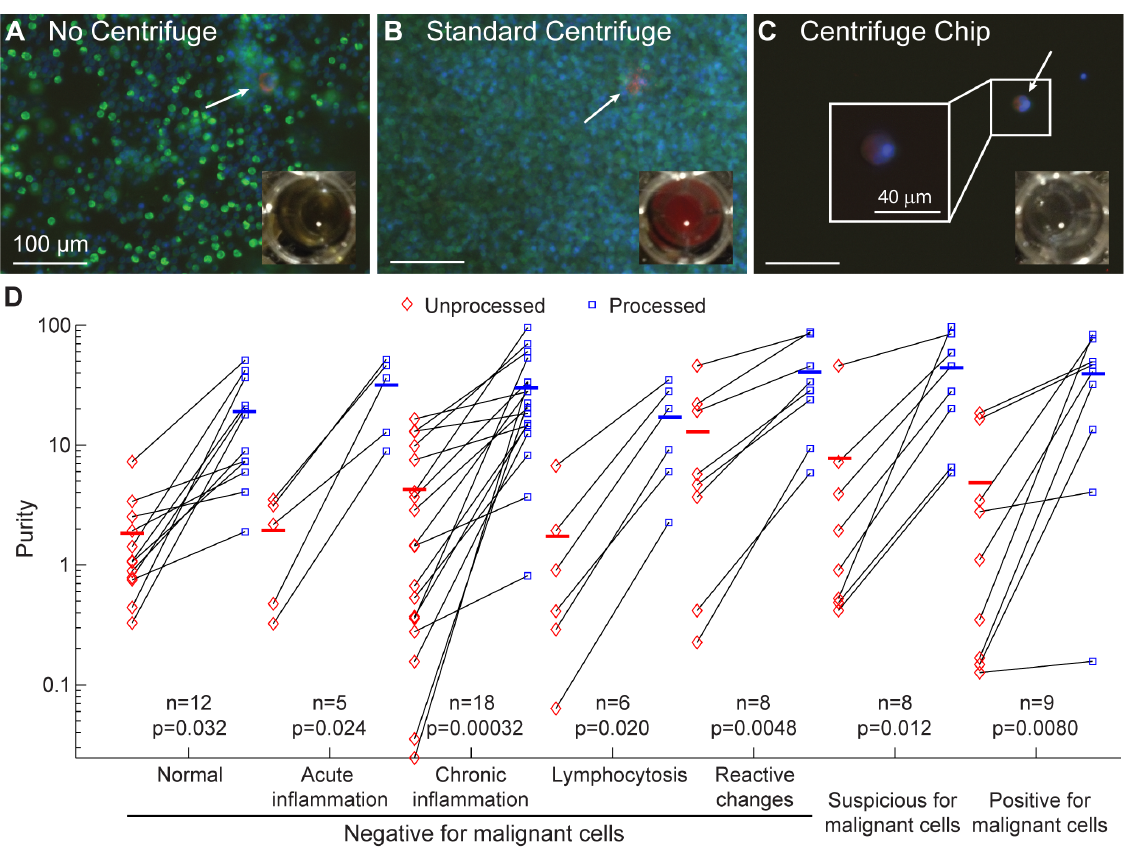
Figure 3. Paired Samples Following Centrifuge Chip Processing Show Purity Increases. (A–C) Qualitative comparison of unprocessed sample, centrifuged sample, and sample processed with the Centrifuge Chip. Immunofluorescent images of Cytokeratin (CK, red – epithelial cells), CD45 (green – leukocytes), and DAPI (blue – nucleus). Insets show well-plate color: yellow (fresh specimen), red (indicating bloody) and colorless (after processing with device). Arrows indicate CK + /DAPI + epithelial cells. (D) Purity increases upon processing with the Centrifuge Chip. Purity is defined as the presence of CK + /DAPI + (epithelial and mesothelial cells) over the total number of cells. All samples (N=66) were seen to increase in purity after processing with the Centrifuge Chip. Red and blue bars represent the average purity.